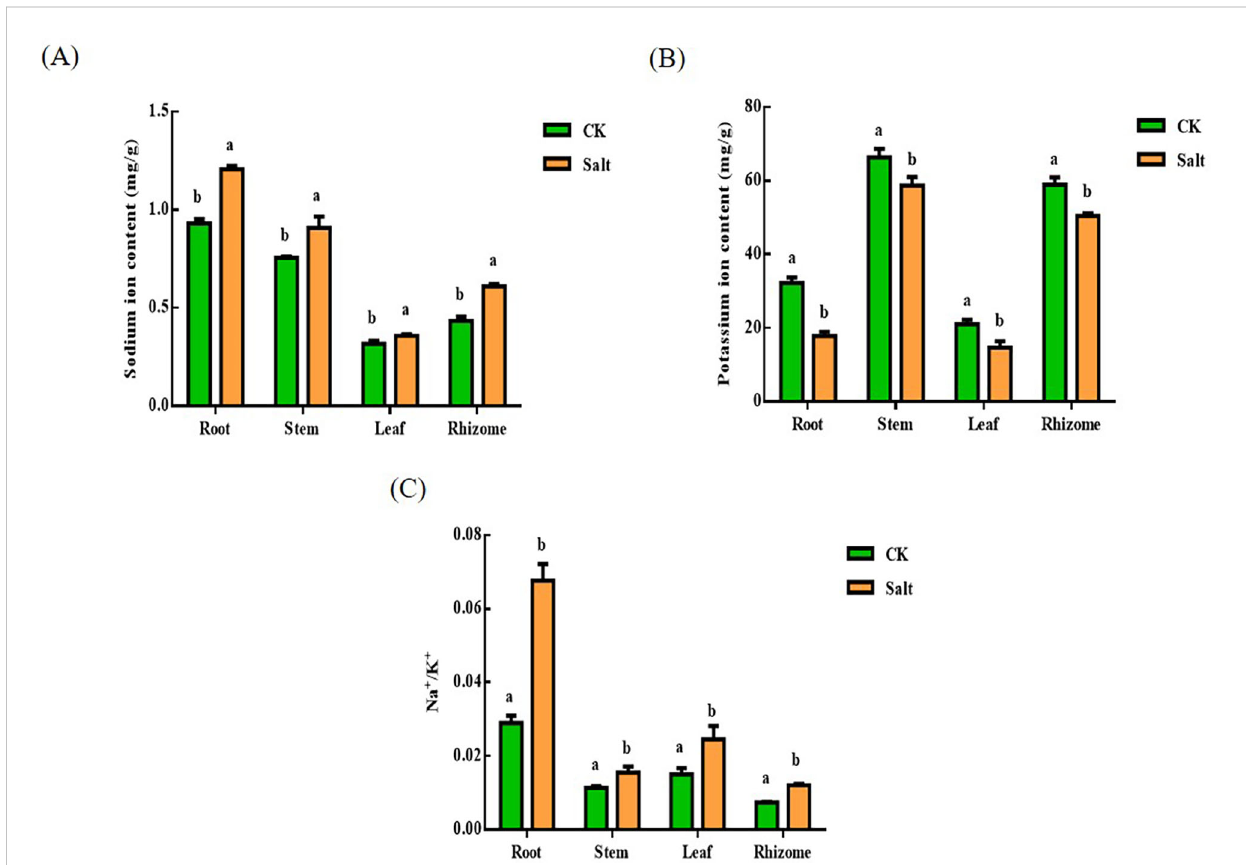
FIGURE 5 Effect of salt stress on the ion content of each part of ginger seedlings. (A) The sodium ion content. (B) The potassium ion content. (C) The ratio of sodium ion content to potassium ion content. The lowercase letters a and b mean the letter markers for signi fi cant difference